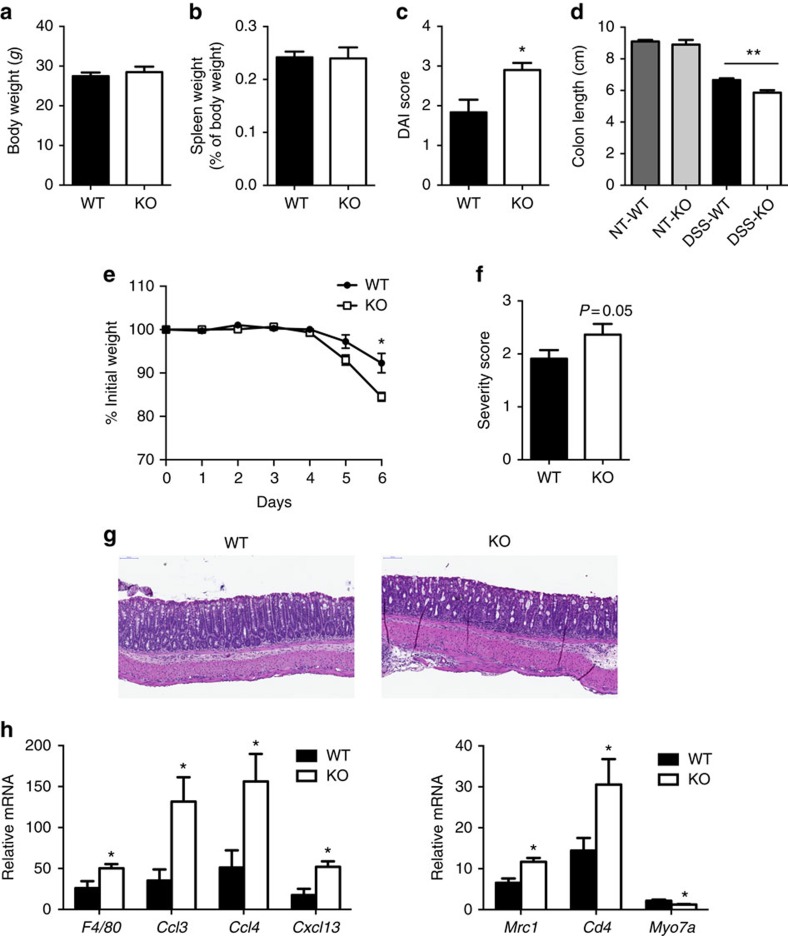
FNDC4 knockout mice show increased inflammation and severity of DSS-induced colitis.(a) Body weights of 12 week old mice, N=4. (b) Spleen weight, standardized to body weight at 16 weeks of age, N=4. (c) DAI (disease activity index). N=5 mice per group. *P<0.05, Mann–Whitney rank test. KO, Fndc4 knockout mice, WT, wild-type mice. (d) Colon length. **P<0.01, analysis of variance with Tukey's post hoc test. (e) Body weight curve. *P<0.05 and q<0.05, Student's T-test followed by the Benjamini-Hochberg false discovery rate correction. (f-g) Histopathology. Colitis severity assessment. N=11 mice per group, *P<0.05, Mann–Whitney rank test. (h) Gene expression, selected genes. *P<0.05; two-sided Student's T-tests, N=5 mice per group. Disease severity was assessed blinded and the experiment was repeated with similar results. Mean±s.e.m.